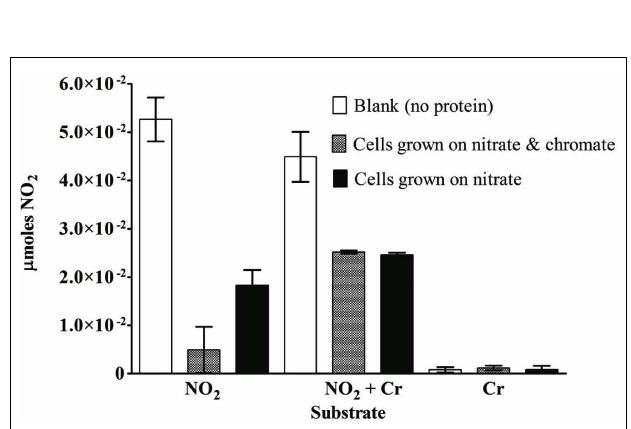
FIGURE 7 |The effect of chromate on nitrate reductase activity in S. barnesii cell lysates. The activity was determined for lysates prepared from cells grown on nitrate medium alone (black bars) or amended with chromate (gray bars).The blank (white bars) contained the reaction mixture without protein.